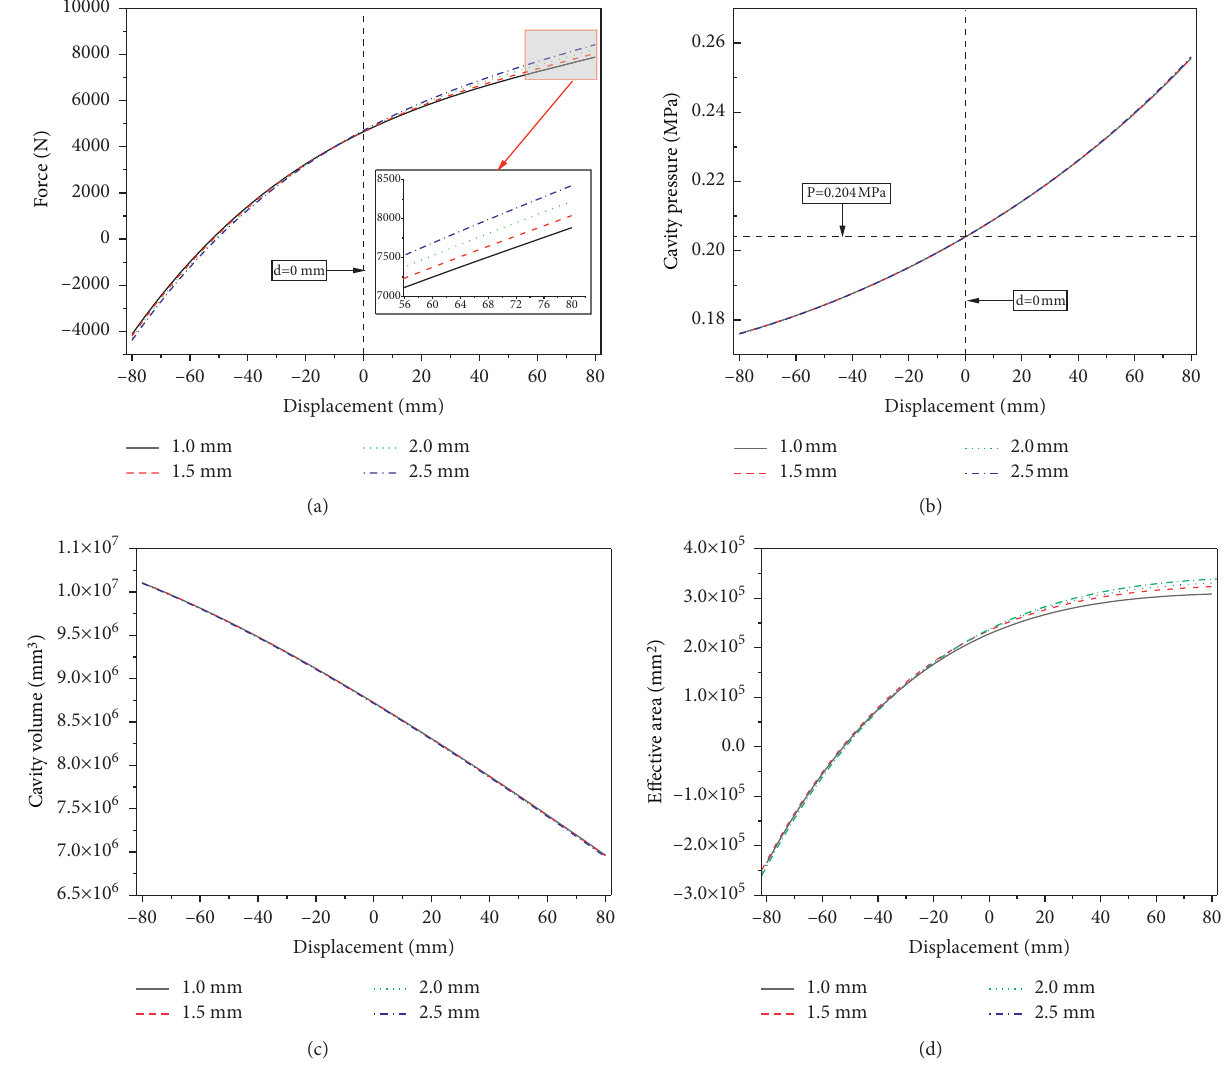
Figure 14: Effect of centre distance on the airbag: (a) force, (b) pressure, (c) volume, and (d) effective